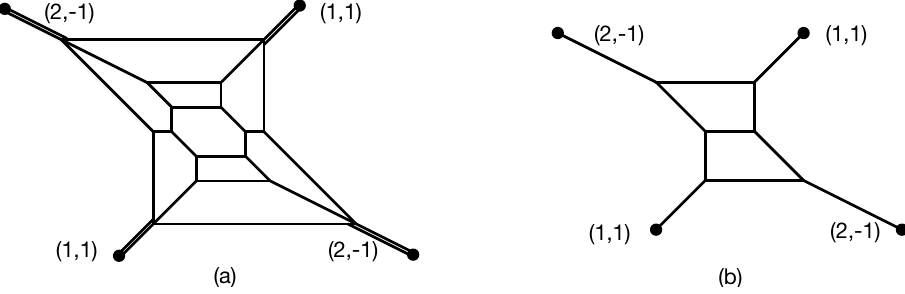
Figure 12 . (a) A 5-brane con(cid:12)guration for SU(6) 0 + 1 TAS and asymptotic charges of external 5-branes. (b) A 5-brane con(cid:12)guration for the pure SU(3) 0 gauge theory. Asymptotic charges of external 5-branes/7-branes for both 5-brane web diagrams are the